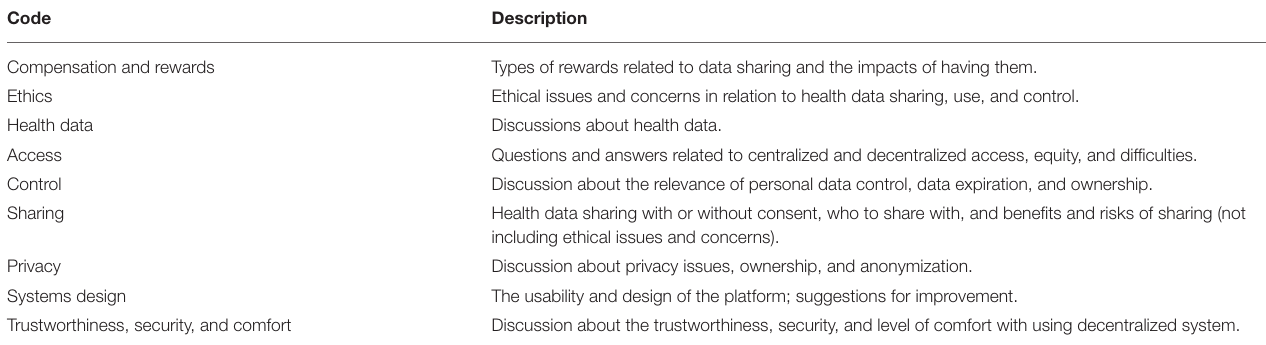
TABLE 1 | Analytic codes extracted from focus group participant